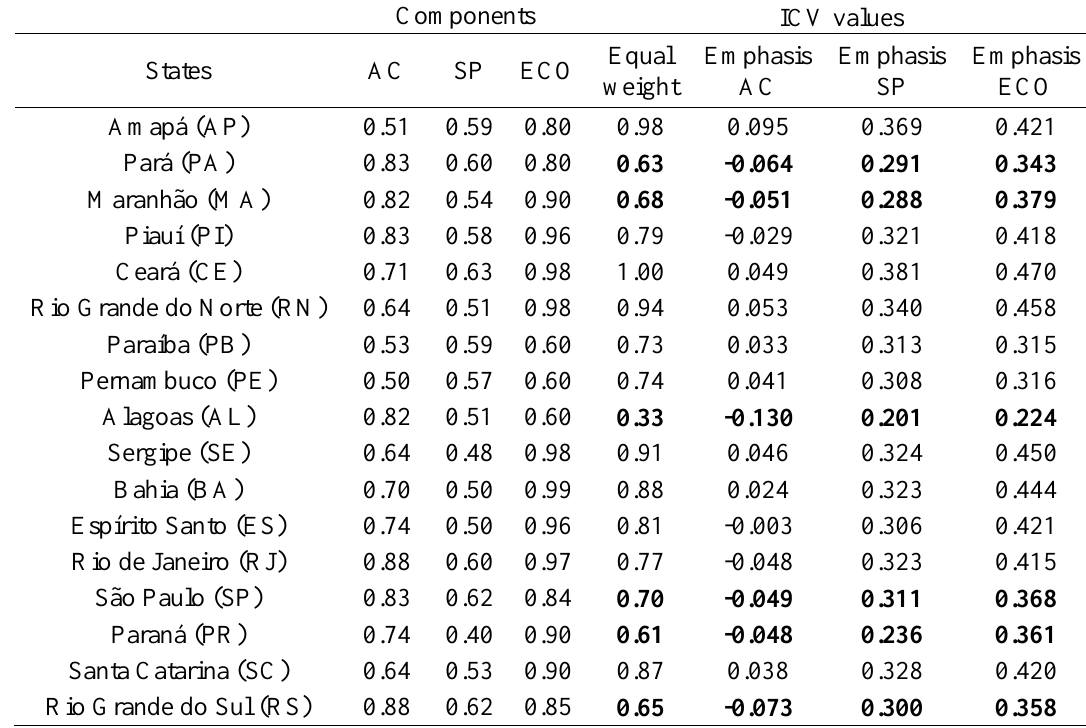
Table A1.1: Components and index values in the weighting scheme: equal weight (same weight among components), Emphasis AC (AC component weighing ½ and the other two weighing ¼), Emphasis SP (SP component weighing ½ and the other two weighing ¼), and Emphasis ECO (ECO component weighing ½ and the other two weighing ¼). AC = Adaptive capacity; SP = Species vulnerability; ECO = Ecosystem vulnerability; ICV = Index of Coastal Vulnerability. Highlighting the most vulnerable states (italic) and the least vulnerable states